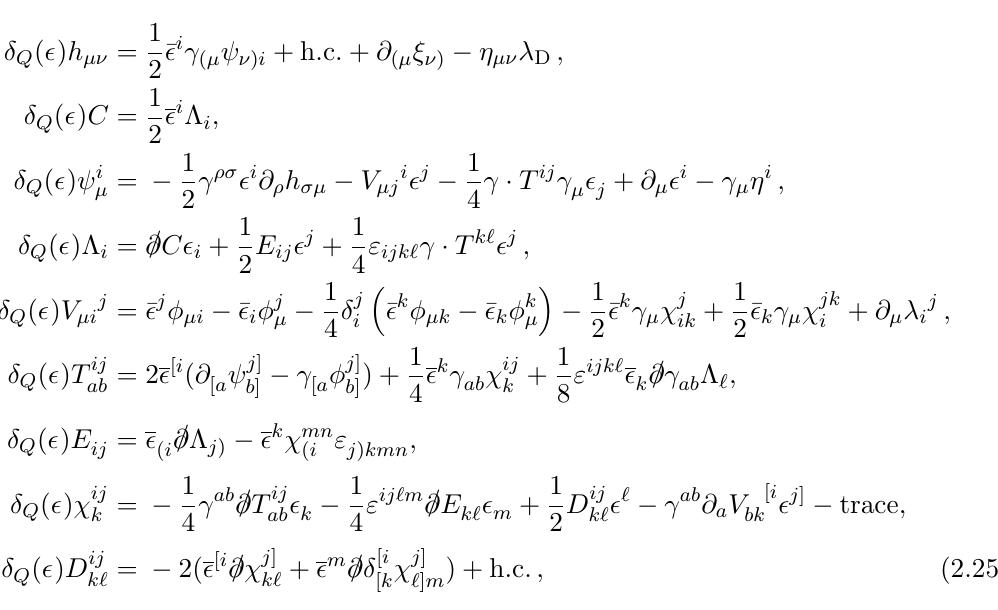
The invariance requirement of the action leads, using the representation properties